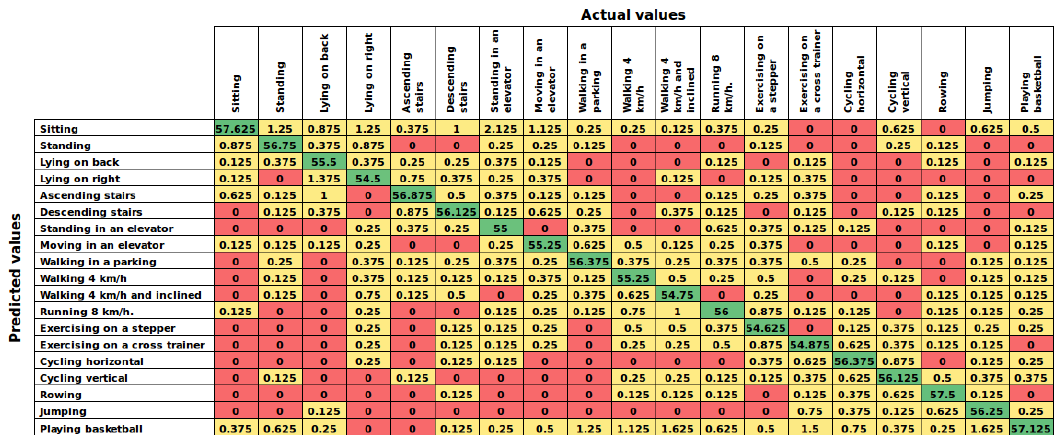
Figure 7. Results of case 2: Confusion matrix of the AHN-classifier in the leave-one subject-out performance for user-independent. Numbers represent the average of window counts in the eight models.